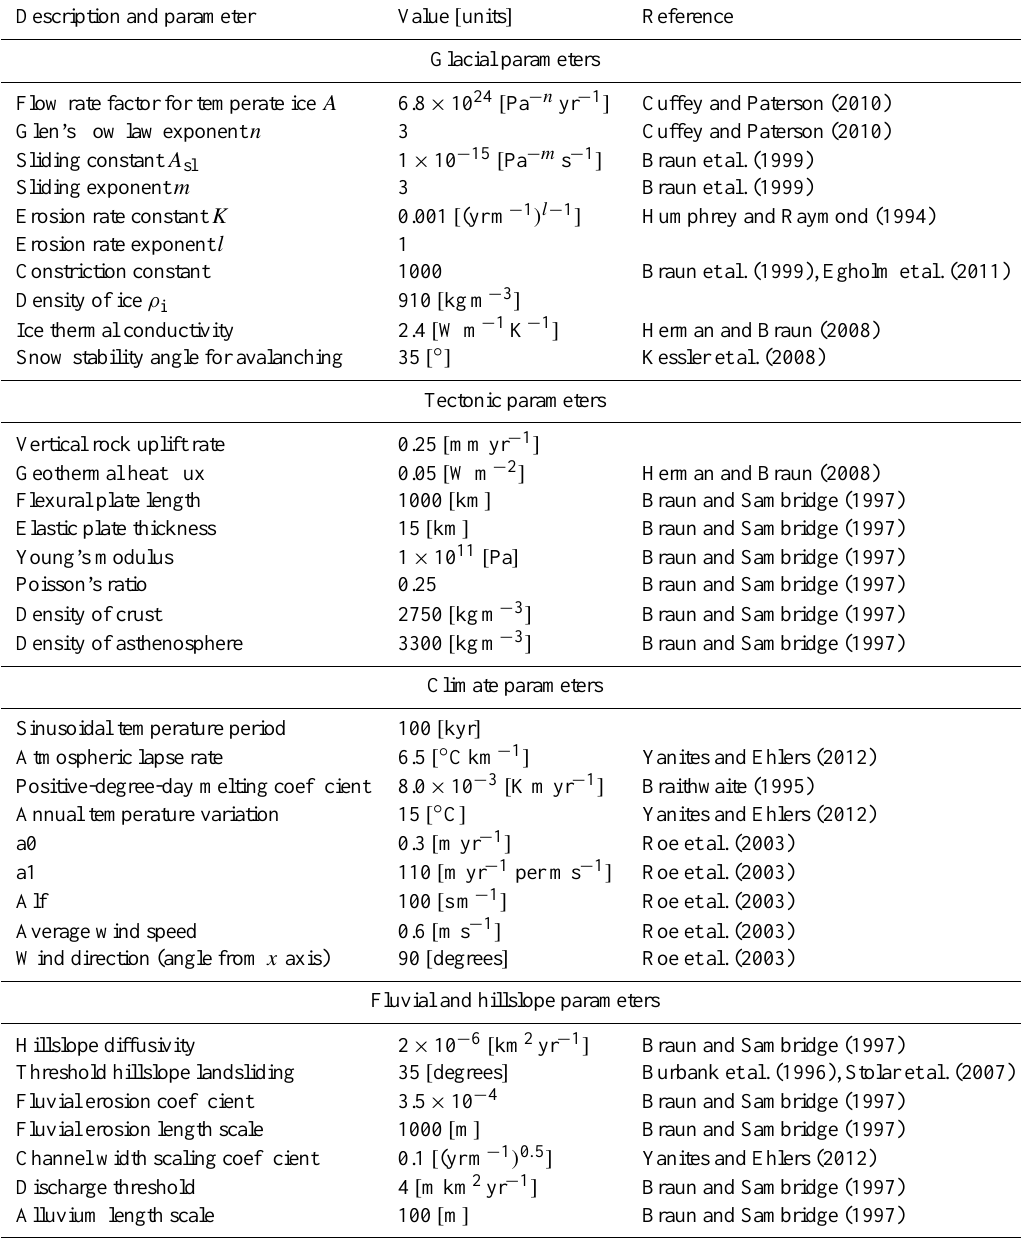
Table 1. Landscape evolution and orographic precipitation model parameters.